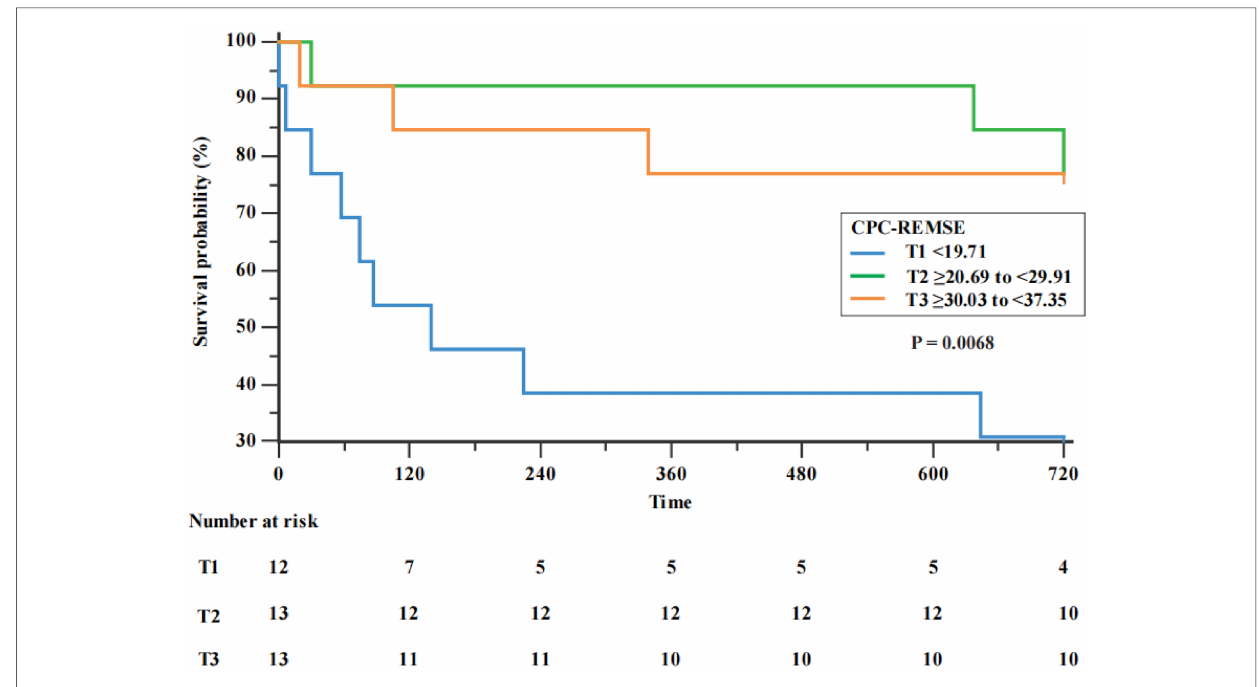
FIGURE 2 Kaplan – Meier survival by stage of